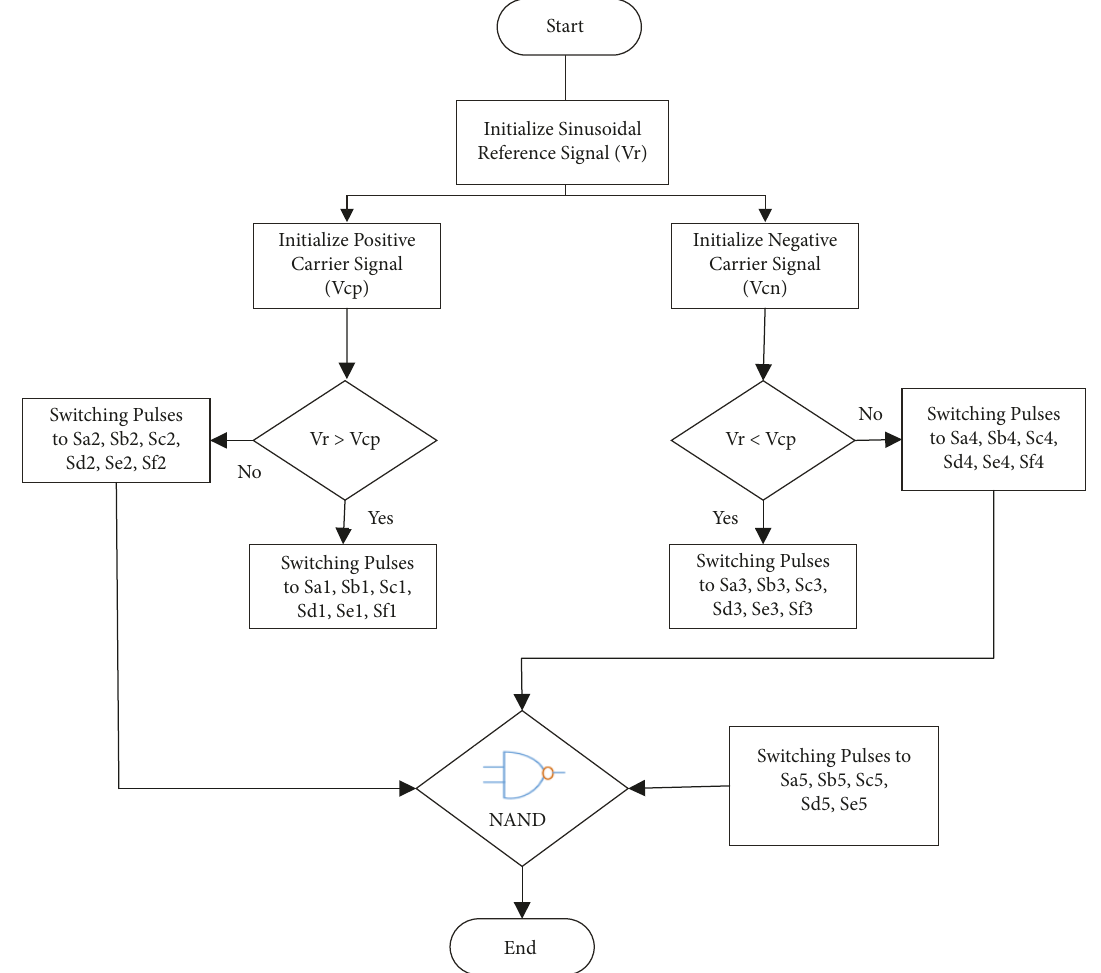
Figure 4: Switching logic